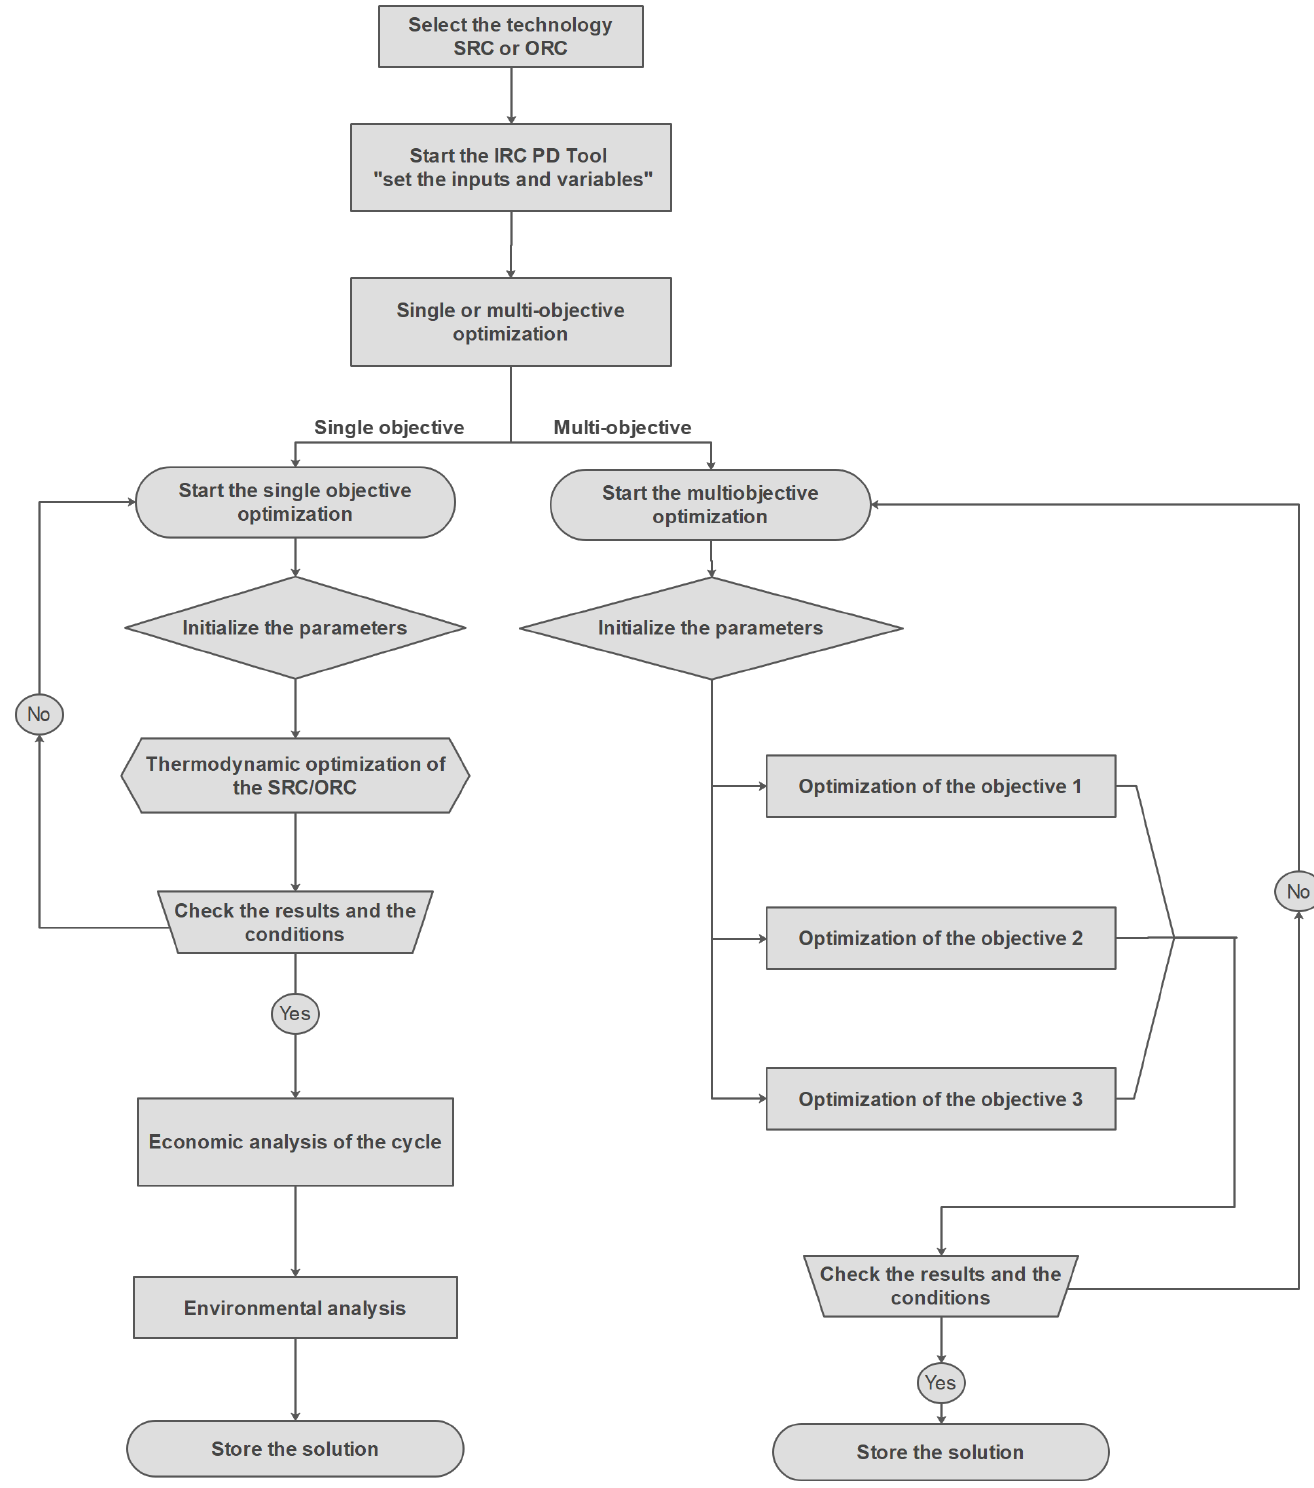
Figure A2. Steps involved during the optimization using the IRC-PD